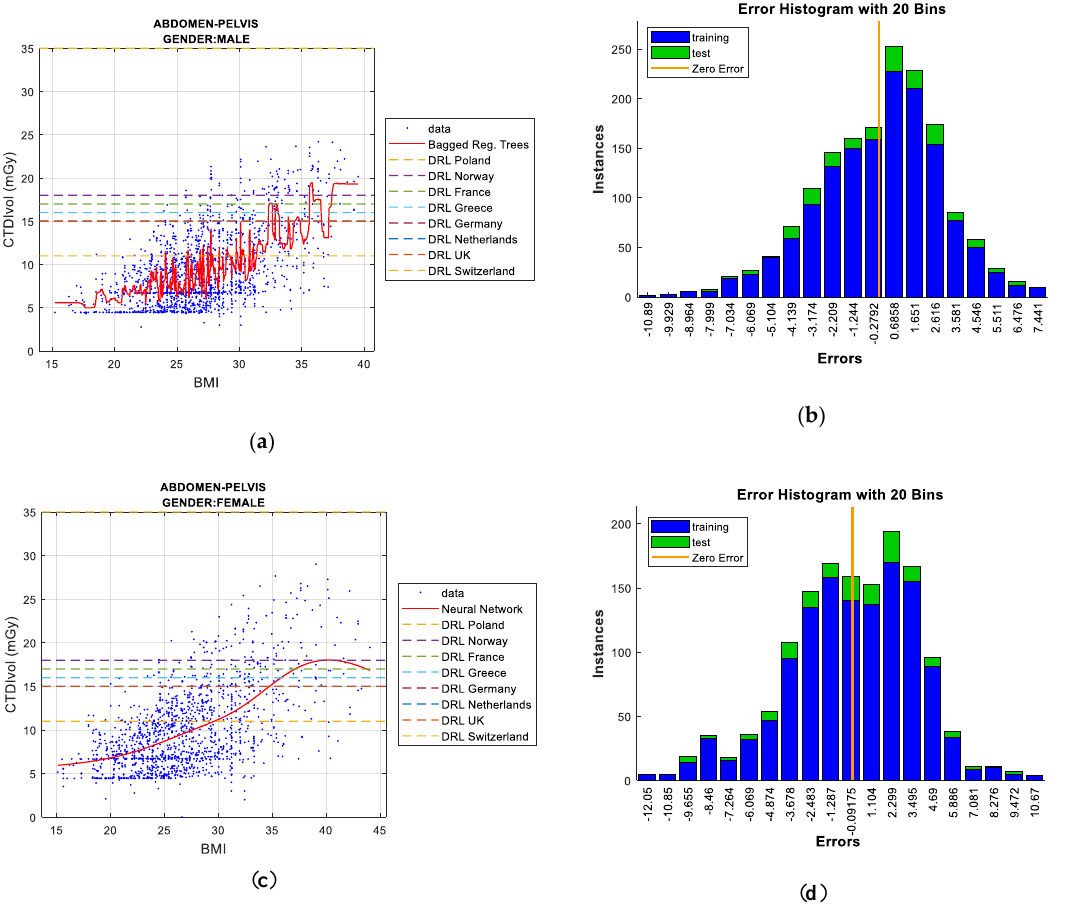
Figure 7. CTDI VOL prediction according to BMI including European DRLs for men’s / women’s abdomen & pelvis protocol ( left ), together with error histograms ( right ), employing the ‘ bagged ’ regression trees ( a , b ) for men and the Neural Networks ( c , d ) for women. Table 9. BMI-CTDI VOL results for women’s Abdomen & Pelvis